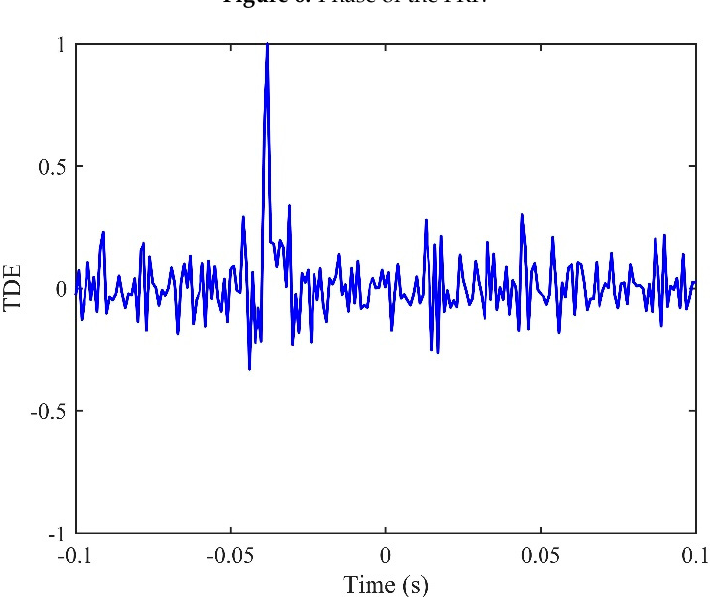
Figure 7. The IRF given by the proposed ADPHAT method for TDE.